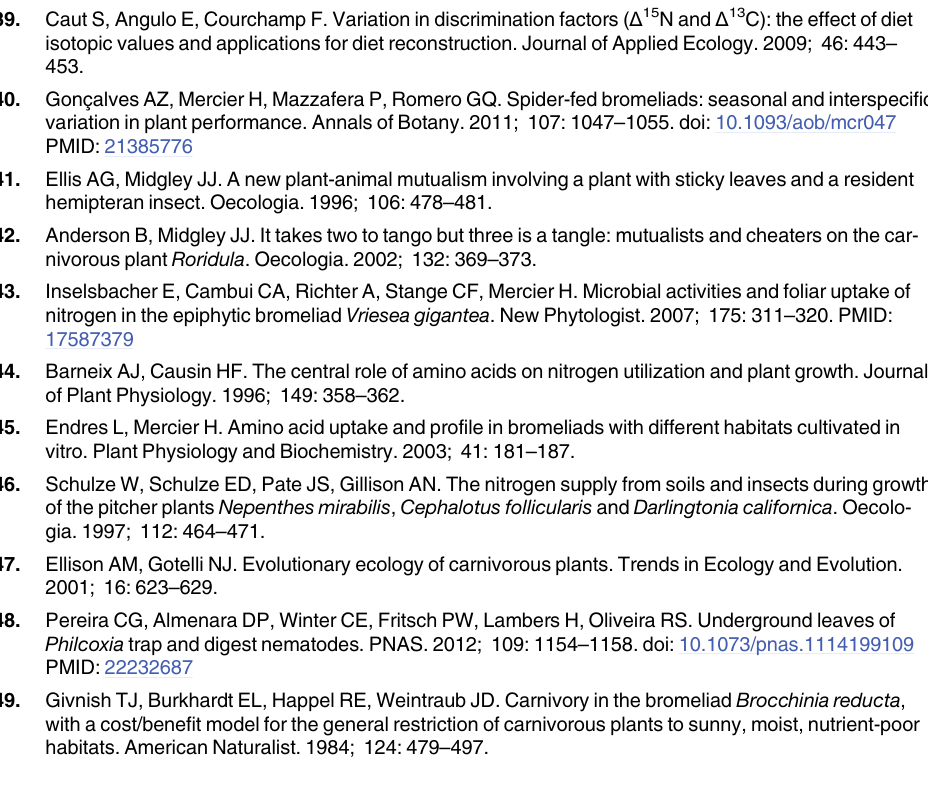
PLOS ONE | DOI:10.1371/journal.pone.0152113 March 22,